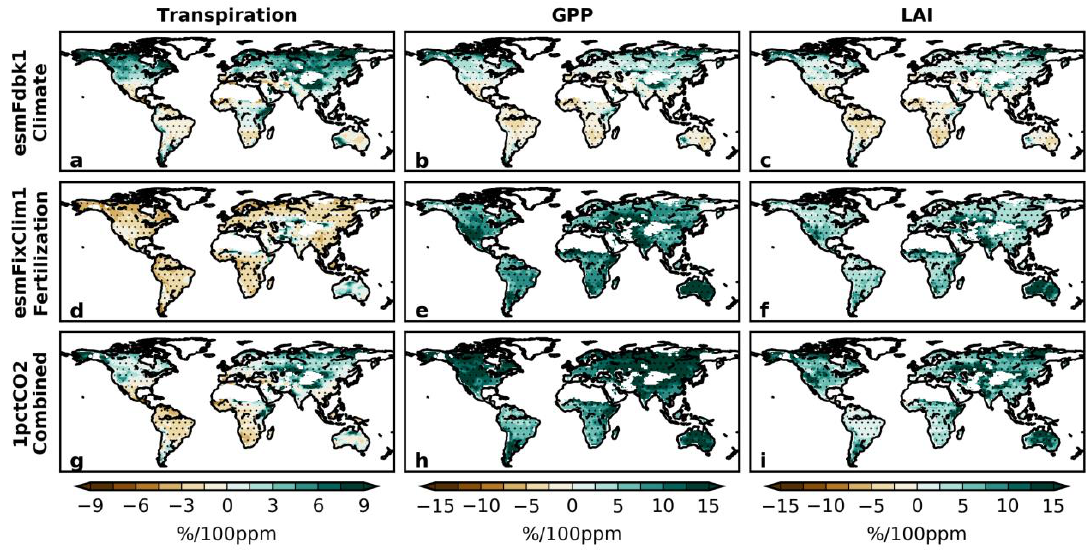
Figure 9. Additive and counteracting impacts of CO 2 on vegetation . Same as Figure 7 except for transpiration, a – c ; GPP, d – f ; and LAI, g – i .